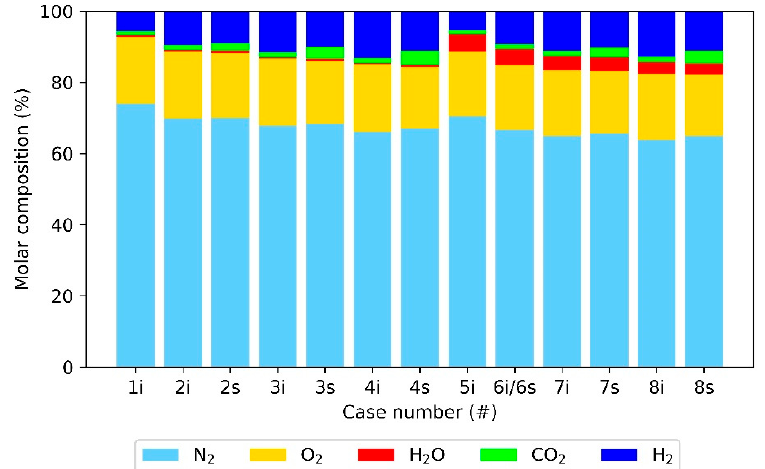
Figure 6. Molar composition of the simulated ignitable mixtures. Numbers from 1 to 8 are associated with the fuel composition as in Figure 2. Indexes ‘i’ and ‘s’ refer to the internal EGR and stable limiting EGR dilution for each mixture.